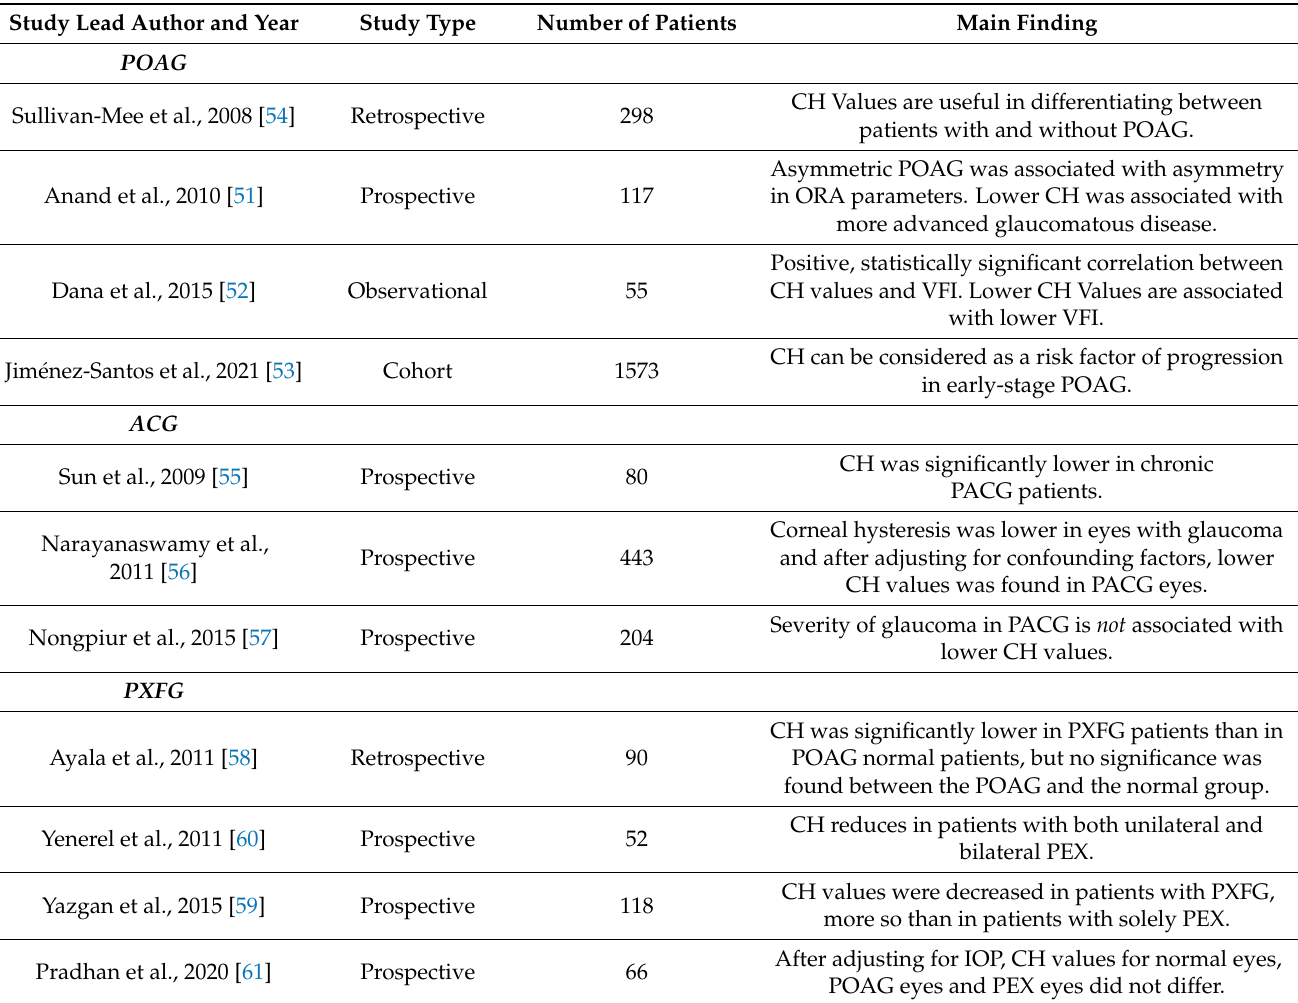
Table 1. Summary of main findings of CH studies in terms of glaucoma detection divided by subtype of